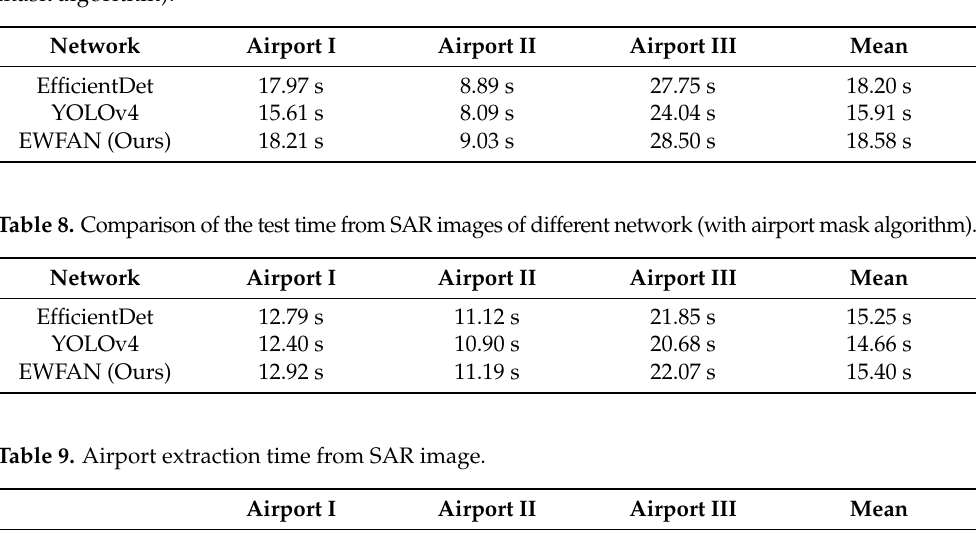
Table 7. Comparison of the test time from SAR images of different network (without airport mask algorithm).